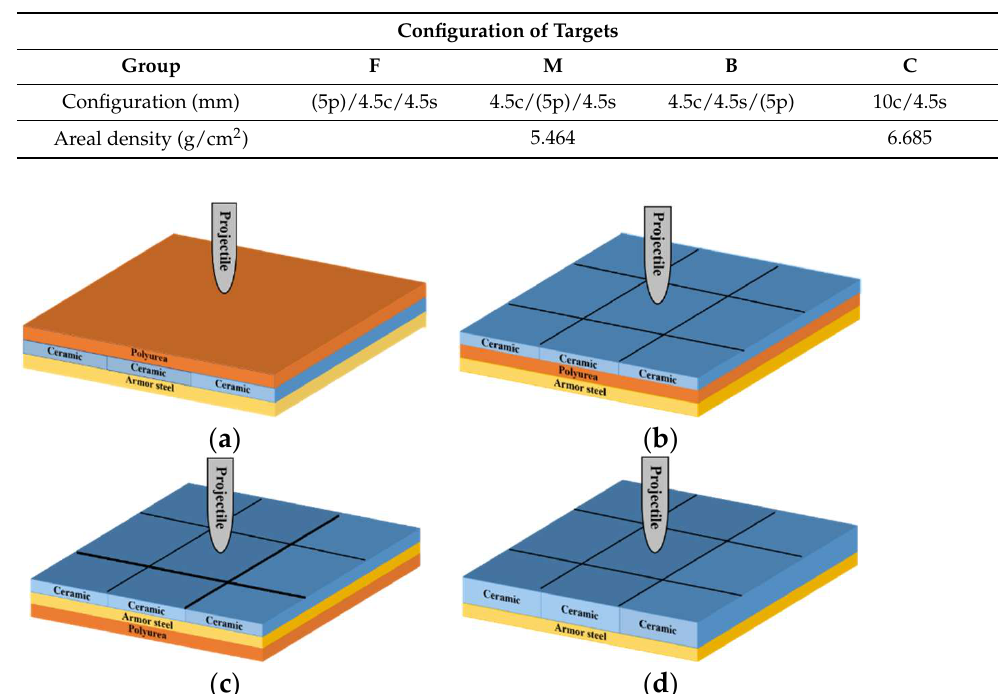
Figure 1. Schematic of the targets: ( a ) Configuration F. ( b ) Configuration M. ( c ) Configuration B. ( d ) Configuration C.